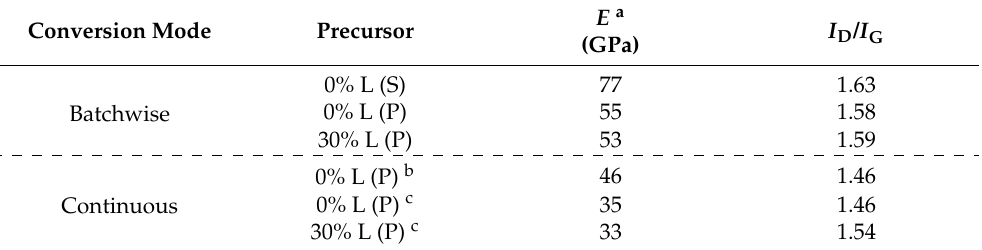
Table 5. Intensity ratio of D to G bands from Raman measurements on CFs prepared by batchwise and continuous conversion. L = Lignin; S = System S; P = System P. Conversion Mode Precursor